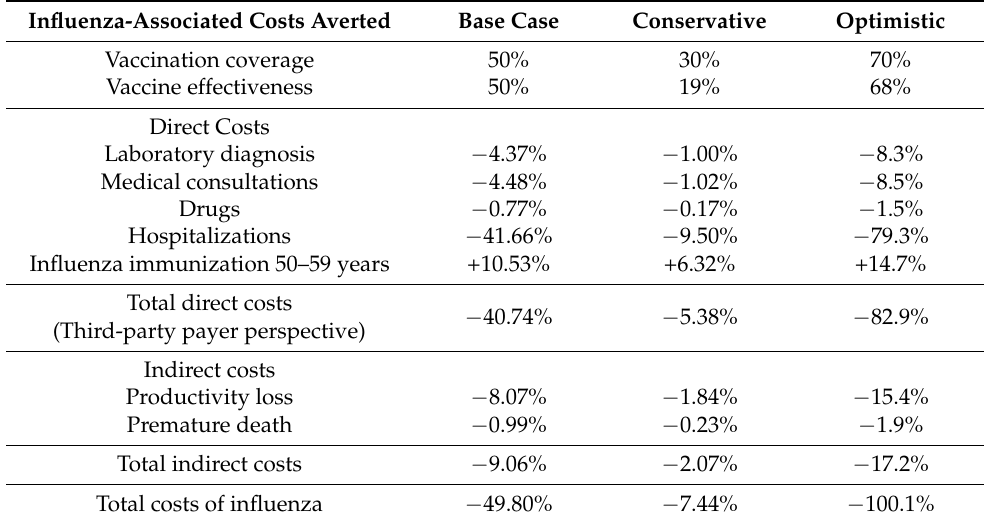
Table 12. Total economic benefits of influenza immunization to the target population 1 : Sensitiv- ity